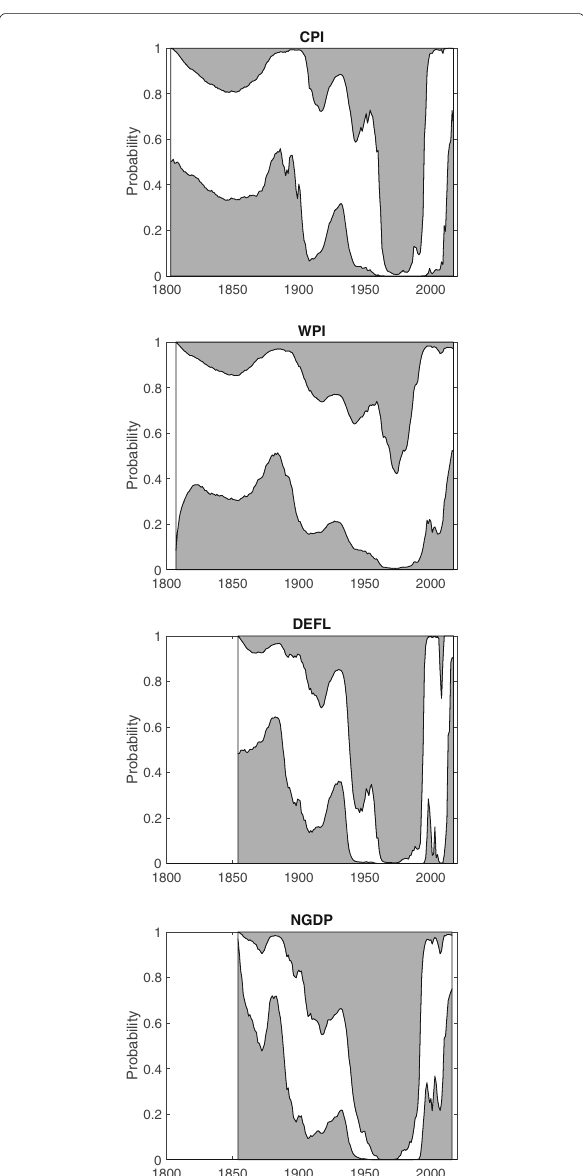
Fig. 3 Probability of nominal stability. The grey areas show the posterior probability that the nominal trend is above or below of today’s definition of nominal stability ( P [ τ < τ t < τ | y ]). The area in between gives the probability of nominal stability. This definition differs among the various indicators. For CPI inflation, the official target range amounts to [0%, 2%], whereas, for the other indicators, no official target ranges exist. To account for the fact that the indicators have different trend growth rates, the CPI target range is adapted by subtracting the average growth rate of the CPI and adding the average growth rate of the various indicators. To obtain a stability range that would be applied in practice, the numbers are rounded to half a percentage point for the WPI ([ − 0.5%,1.5%]), the GDP deflator ([0%,2%]), and nominal GDP